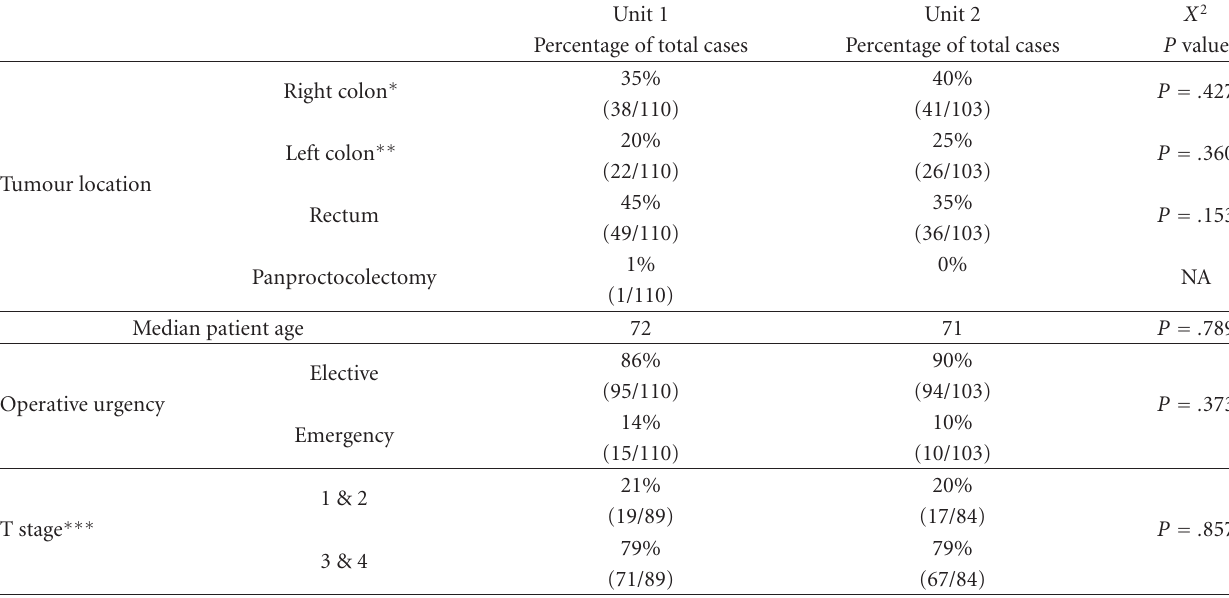
Table 1: Case mix between units.